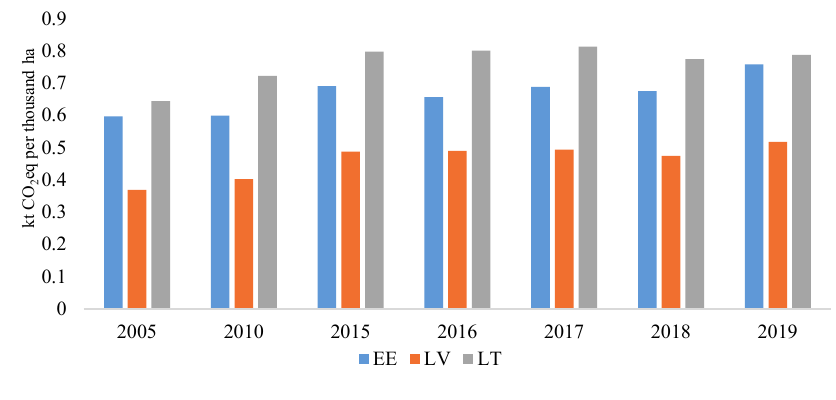
Fig. 1. GHG emissions per agricultural area (kilotons CO 2 eq. per thousand hectares) [12].